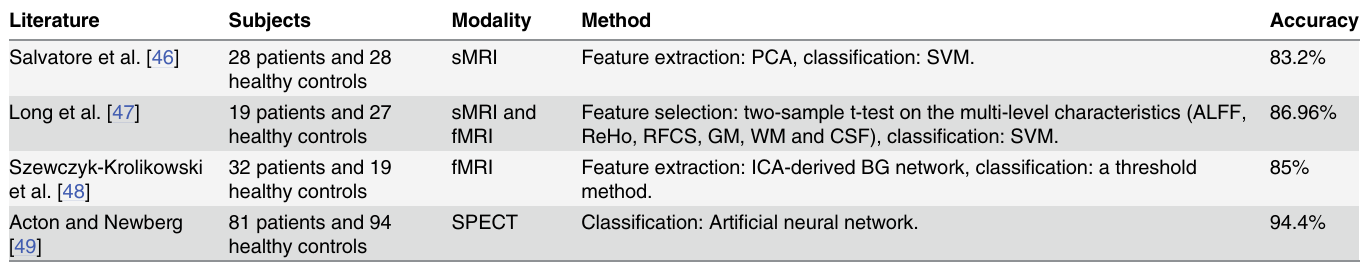
Table 3. Existing studies regarding Parkinson ’ s disease